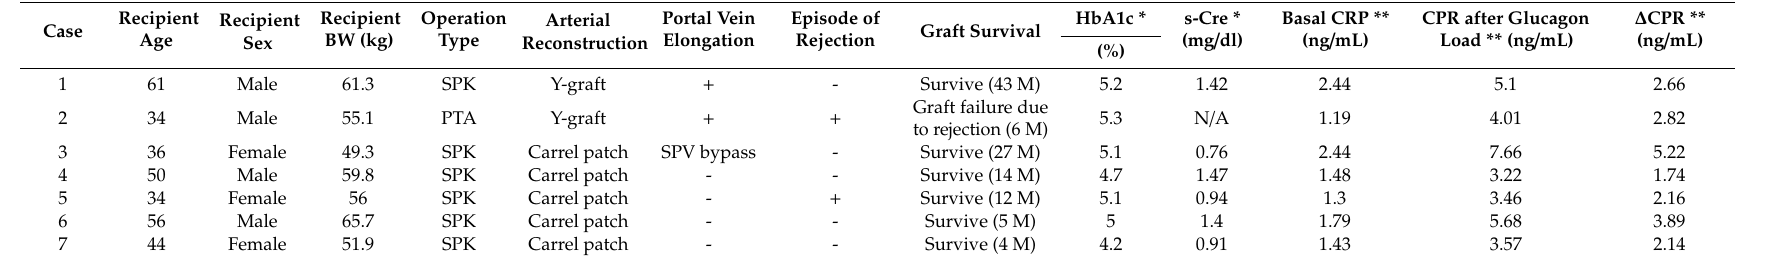
Table 2. Recipient background and the results of